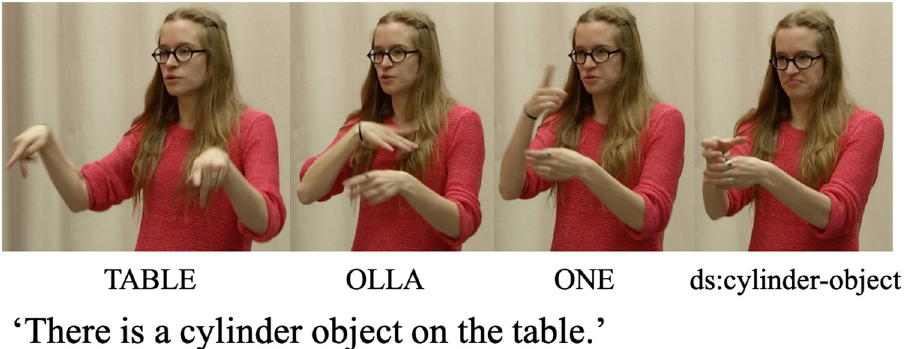
Figure 15: An example of a sequential strategy without an adposition sign and a new Figure entity depicted on the conceptually maintained location where the Ground was